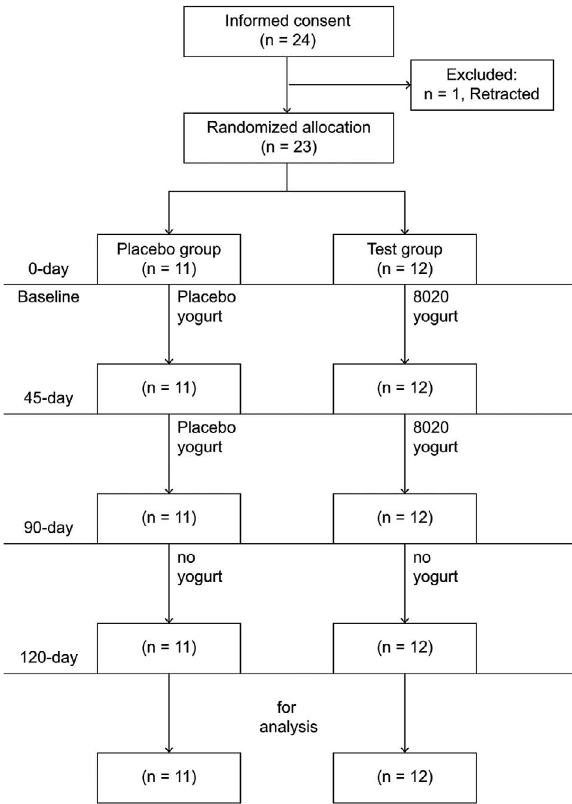
Figure 1- Study flowchart. Individuals with intellectual disability were allocated to receive L8020 yogurt (bovine milk fermented with Lactobacillus rhamnosus L8020; test group) or a conventionally prepared commercial yogurt (placebo group). The study parameters were measured before the start of yogurt consumption (baseline), after 45 and 90 days of continuous daily yogurt consumption, and 30 days after cessation of yogurt